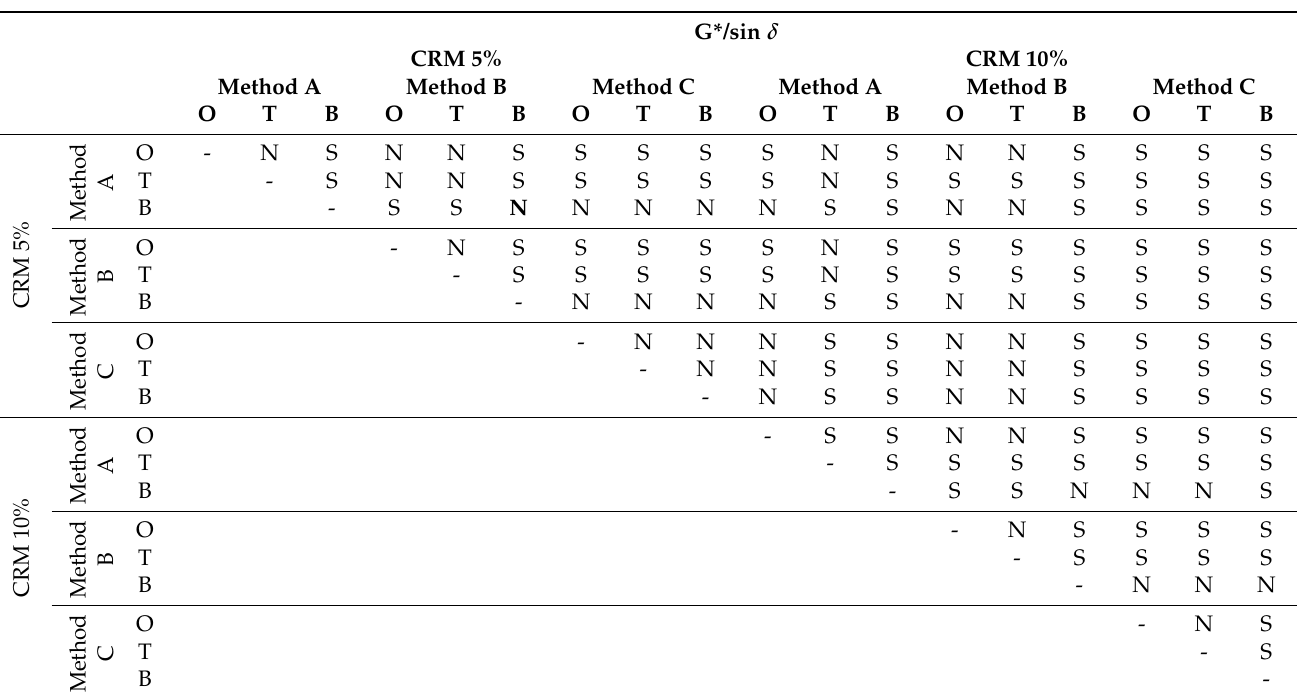
Table 4. Statistical analysis results of the G*/sin δ of the CRM binders as a function of the original, top, and bottom parts ( α =